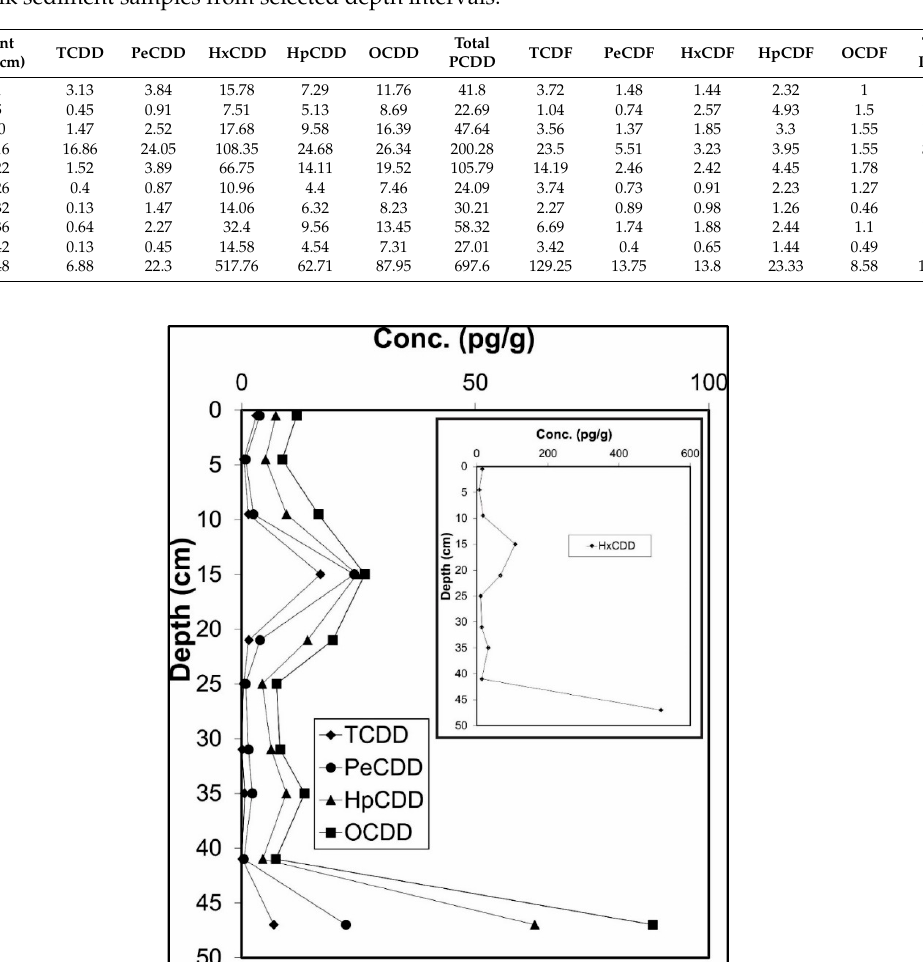
Figure 8. Downcore variation in furan homologue concentration for bulk sediment samples. Inset shows TCDF, which is present at significantly higher concentrations than the other homologues.